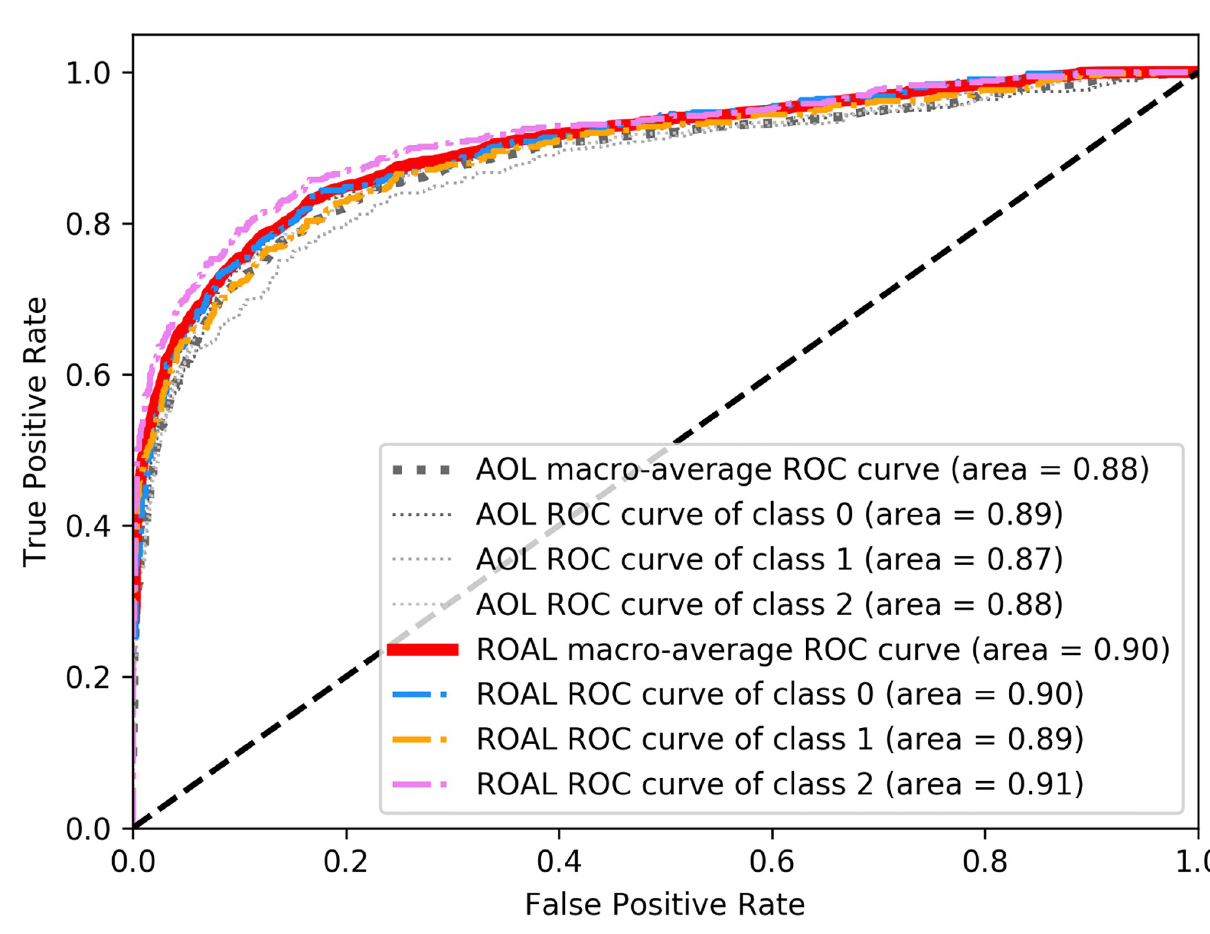
Fig 6. ROC plot with AUC values for AOL and